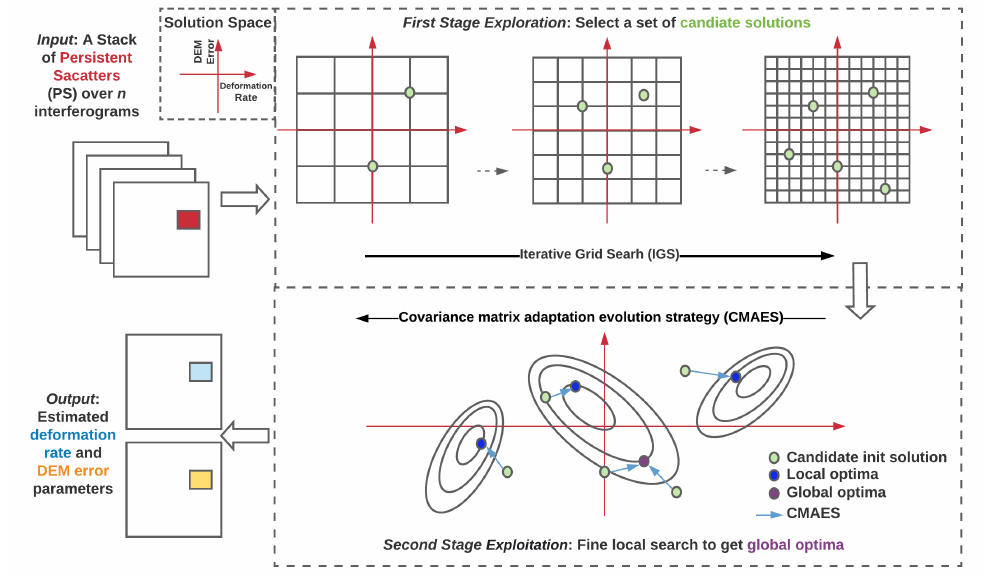
Figure 2. Illustration of proposed two-stage iterative grid search with covariance matrix adaptation evolution strategy (IGS-CMAES)